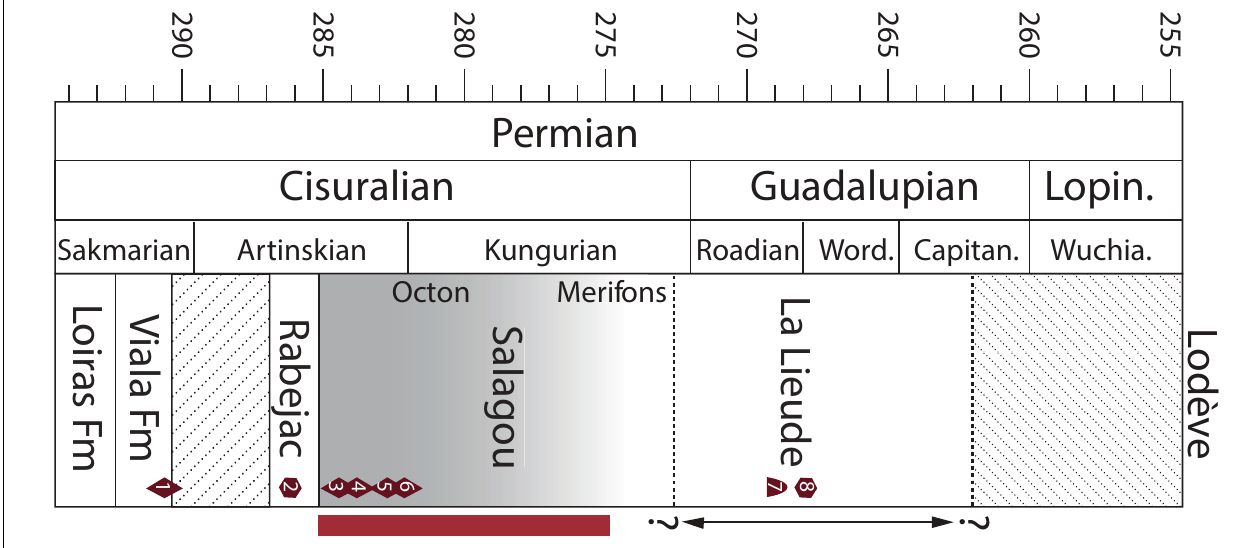
to pre-whiten the stratigraphic series, for clarity in evaluating stratigraphic cyclicity potentially related to orbital